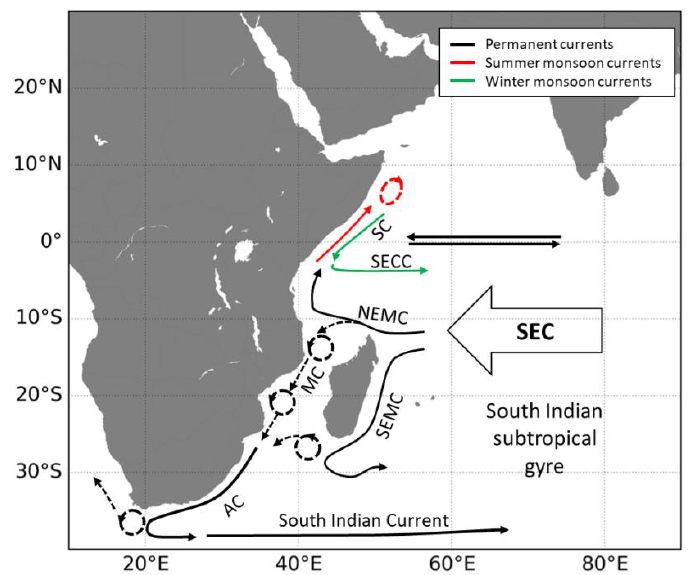
Figure A1. Schematic representation of the surface currents in the west Indian Ocean. Permanent currents are in black. Currents flowing during the summer monsoon are in red. Those flowing during the winter monsoon are in green. SC: Somali Current (reverses between the summer and the winter monsoon); SECC: South Equatorial Counter Current; SEC: South Equatorial Current; NEMC: Northeast Madagascar Current; SEMC: Southeast Madagascar Current; EACC: East African Coast Current;